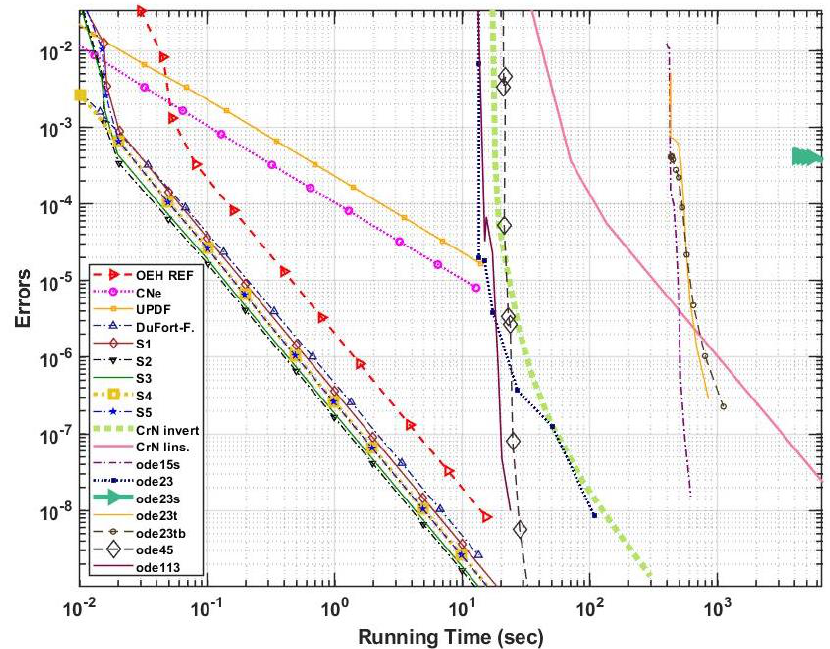
Figure 4. Errors as a function of the running time for the first (moderately stiff) system, in the case of the original OEH method (OEH REF), one-stage CNe and UPFD methods, the Dufort–Frankel method, the new Algorithms S1–S5, and the Crank–Nicolson with two implementations and different MATLAB routines.